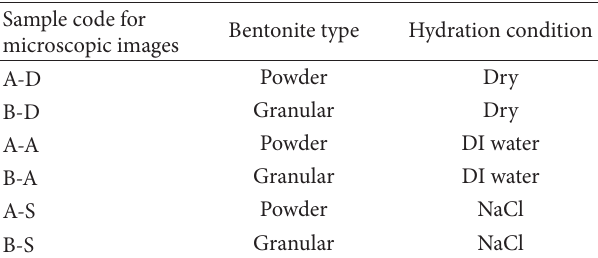
Table 1: GCL sample